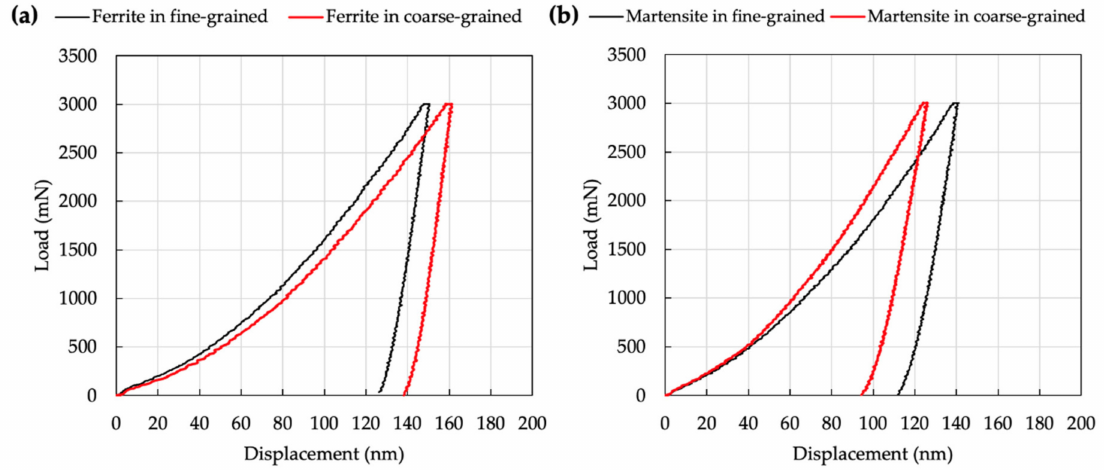
Figure 17. Representative load displacement curve of FG and DG areas for sample A: ( a ) ferrite and ( b )